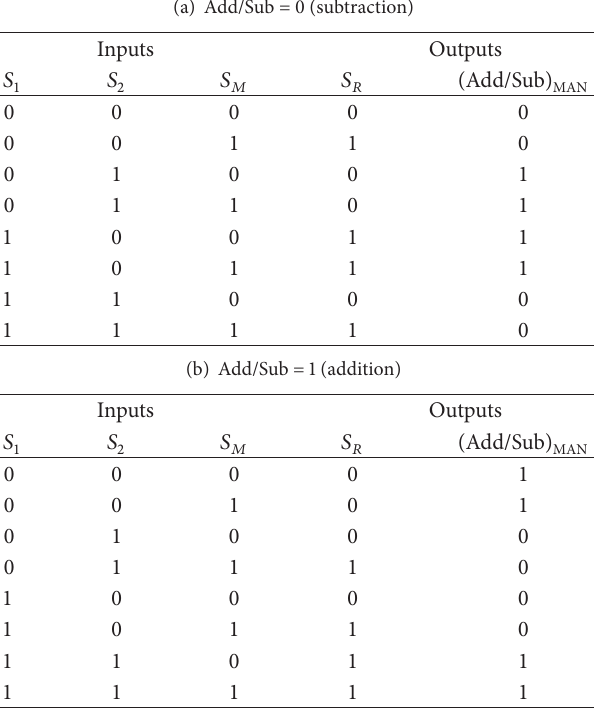
Table 5: FAU control logic truth tables.